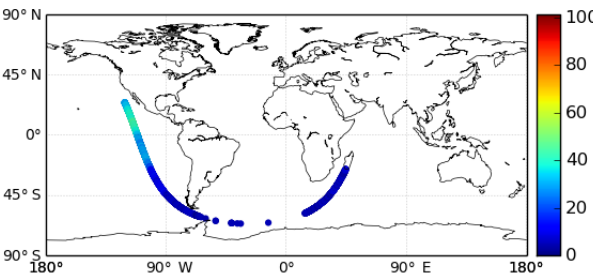
Figure 8. Ground track of the Jason-2 altimetry satellite between 00:00 and 01:00UTC on DOY 229, 2016. The colors show the mag- nitude of VTEC in TECU acquired from the satellite.